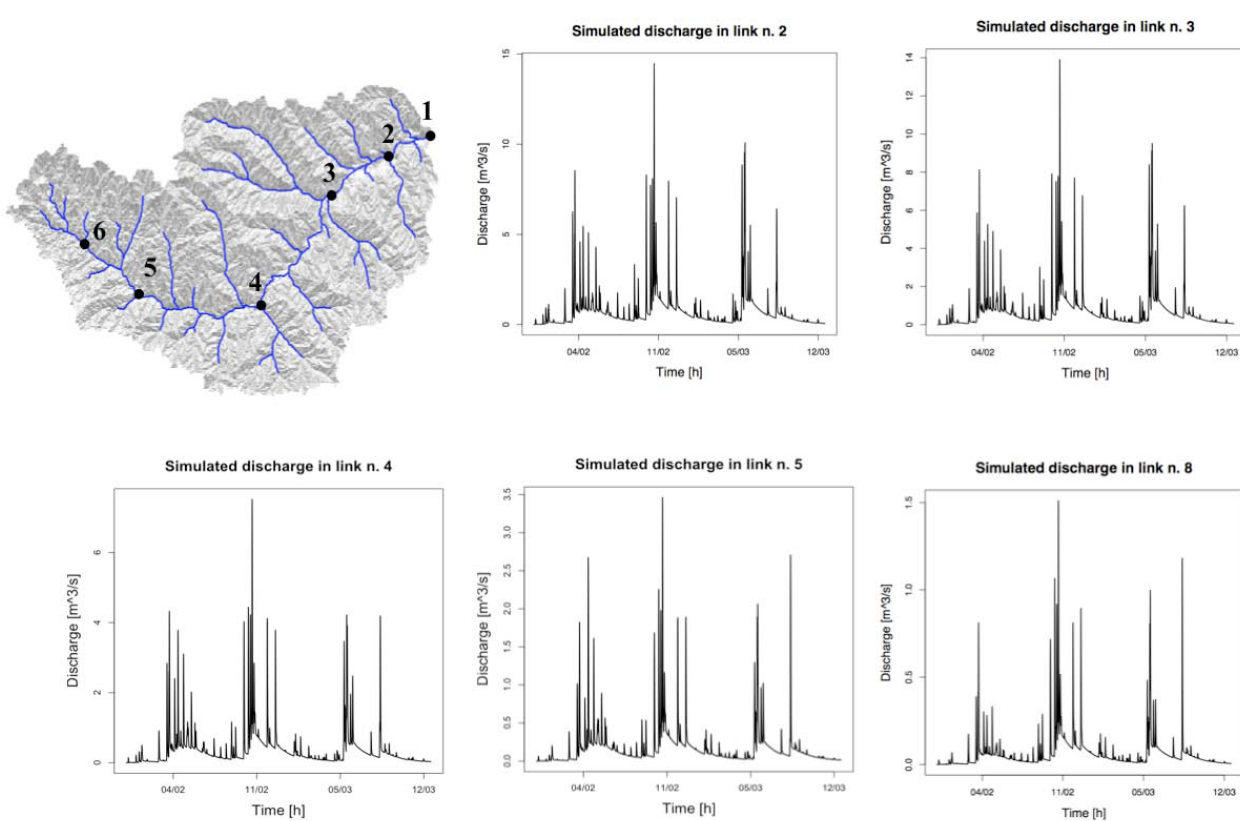
Fig. 9. Application of the JGrass-NewAge model for the period 01/01/2002 to